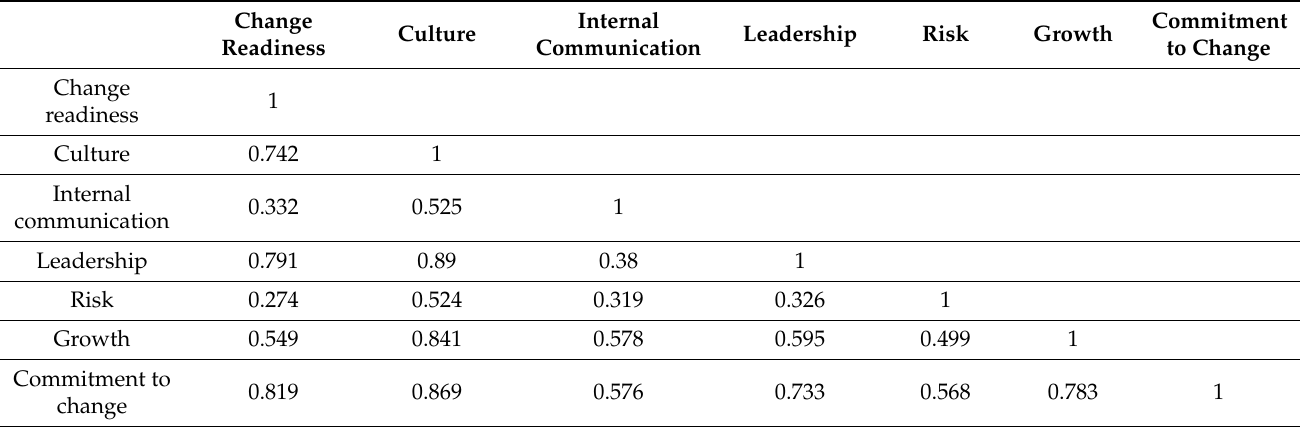
Table 4. Overall construct correlation matrix